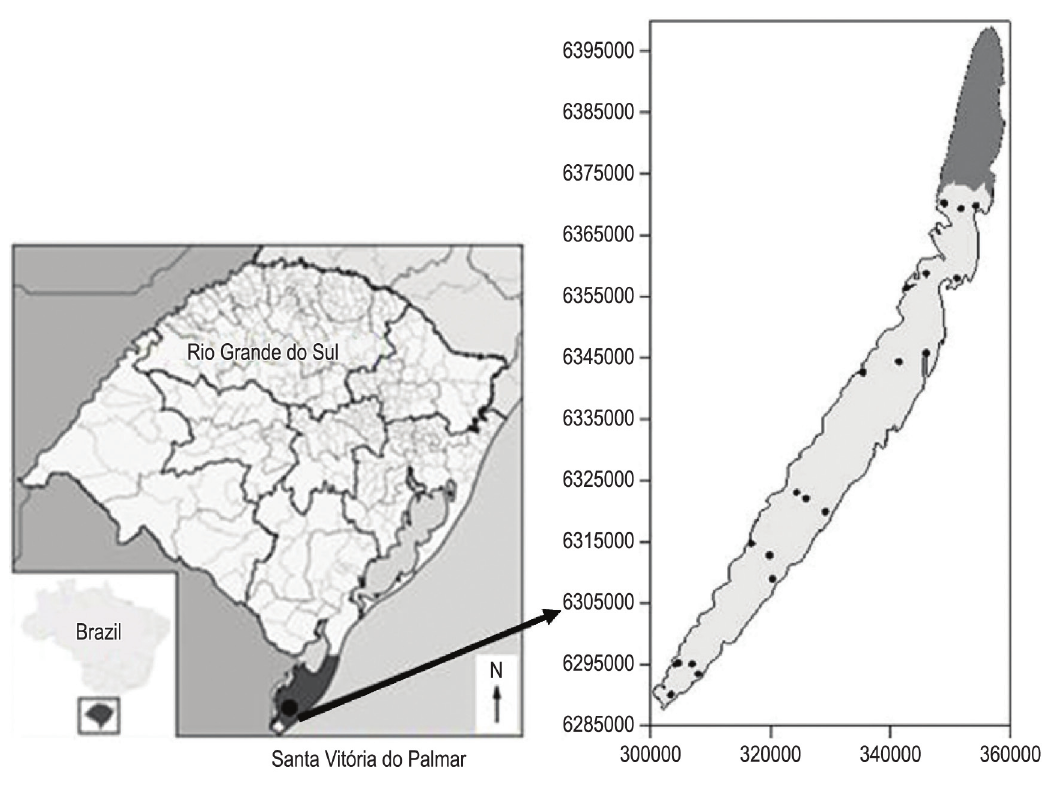
Figure 1. Location of Lake Mangueira in Santa Vitória do Palmar, state of Rio Grande do Sul, Brazil. Black circles indicate the 19 sampling points. Dark gray shading at the northern end of the lake indicates the Taim